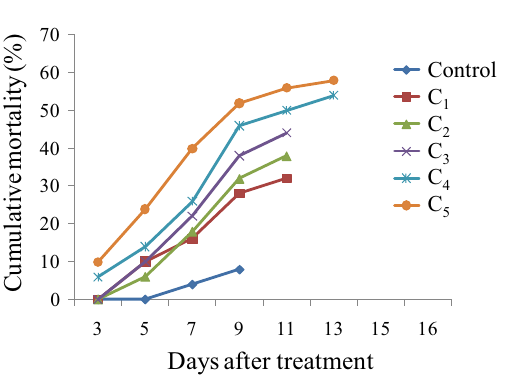
Figure 3. Mean cumulative mortality of second instar larvae of S. litura fed on castor leaves treated with different concentrations (C 1 = 2.6 × 10 8 cfu/ml, C 2 = 6.4 × 10 8 cfu/ml, C 3 = 1.6 × 10 9 cfu/ml, C 4 = 3.0 × 10 9 cfu/ml and C 5 = 5.2 × 10 9 cfu/ml) of S. marcescens